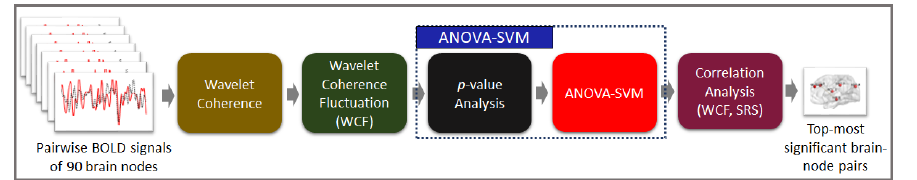
Figure 3. Method of selecting the most significant brain-node pairs from wavelet coherence using WCF, ANOVA-SVM and correlation analysis between WCF and